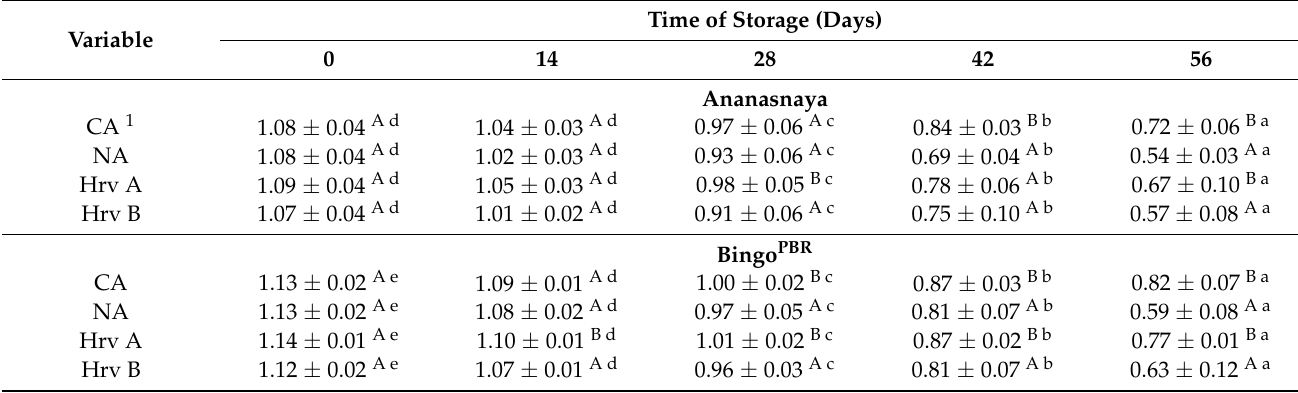
Table 3. Changes of titratable acidity [% citric acid] measured in ‘Ananasnaya’ and ‘Bingo’ PBR minikiwi fruit in postharvest